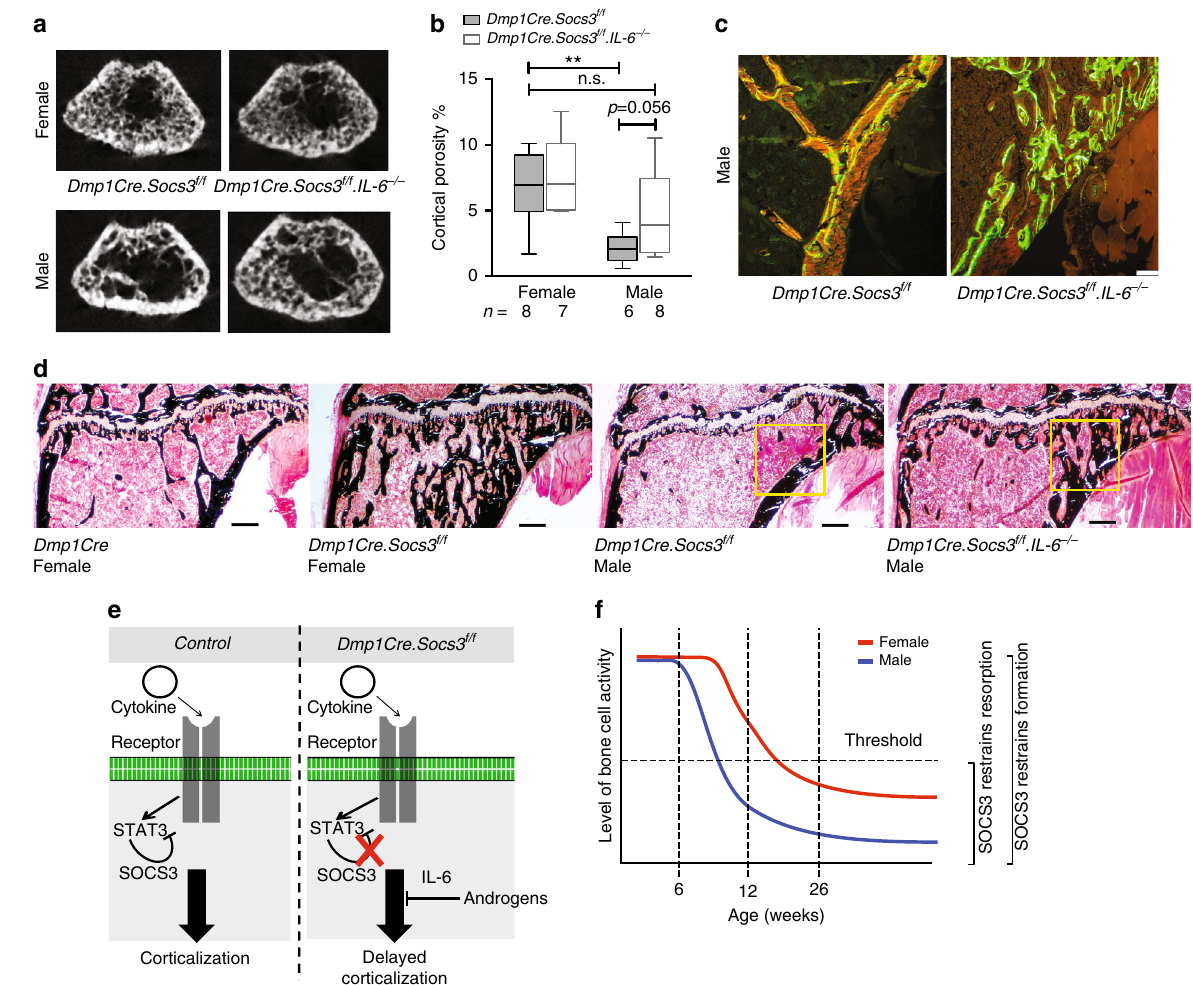
Fig. 7 IL-6 deletion partially rescues the sex-speci fi c difference in corticalization in Dmp1Cre.Socs3 f/f mice. a Representative images of the top slice from the femoral metaphys is of 12-week-old female and male Dmp1Cre.Socs3 f/f and Dmp1Cre.Socs3 f/f . IL-6 − / − littermates. b Cortical porosity (box plots with whiskers showing minimum and maximum values) in the femoral metaphysis of female and male Dmp1Cre.Socs3 f/f and Dmp1Cre.Socs3 f/f . IL-6 − / − littermates; n per group is shown below the graph; ** p < 0.01 for comparison shown, determined by two-way ANOVA with Sidak post-hoc test. c Calcein labeling in the corticalization zone in male Dmp1Cre.Socs3 f/f and Dmp1Cre.Socs3 f/f . IL-6 − / − littermates on the lateral side of the tibial metaphysis (boxed region shown ( d )). c Representative images showing the morphology of longitudinal sections of the lateral side of the tibial metaphysis in control female mice, Dmp1Cre.Socs3 f/f females, Dmp1Cre.Socs3 f/f males, and Dmp1Cre.Socs3 f/f .IL-6 − / − males. Scale bar = 100 µ m. Note the change in corticalization at